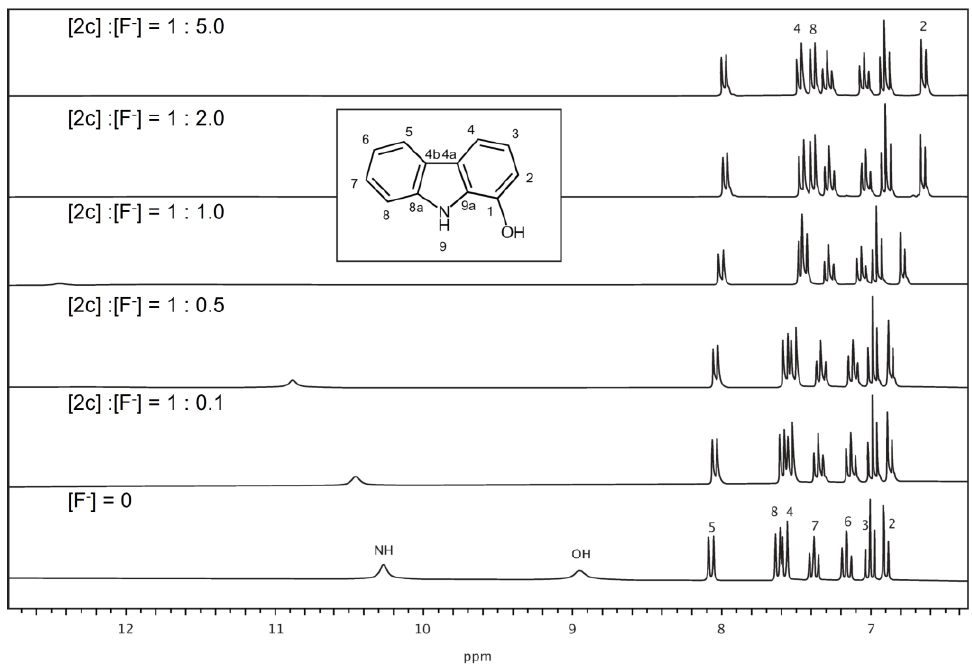
Figure 6. 1 H-NMR spectra of fluorescence sensor 2c in d 6 -acetone in the presence of fluoride anions at molar ratio indicated over each spectrum.